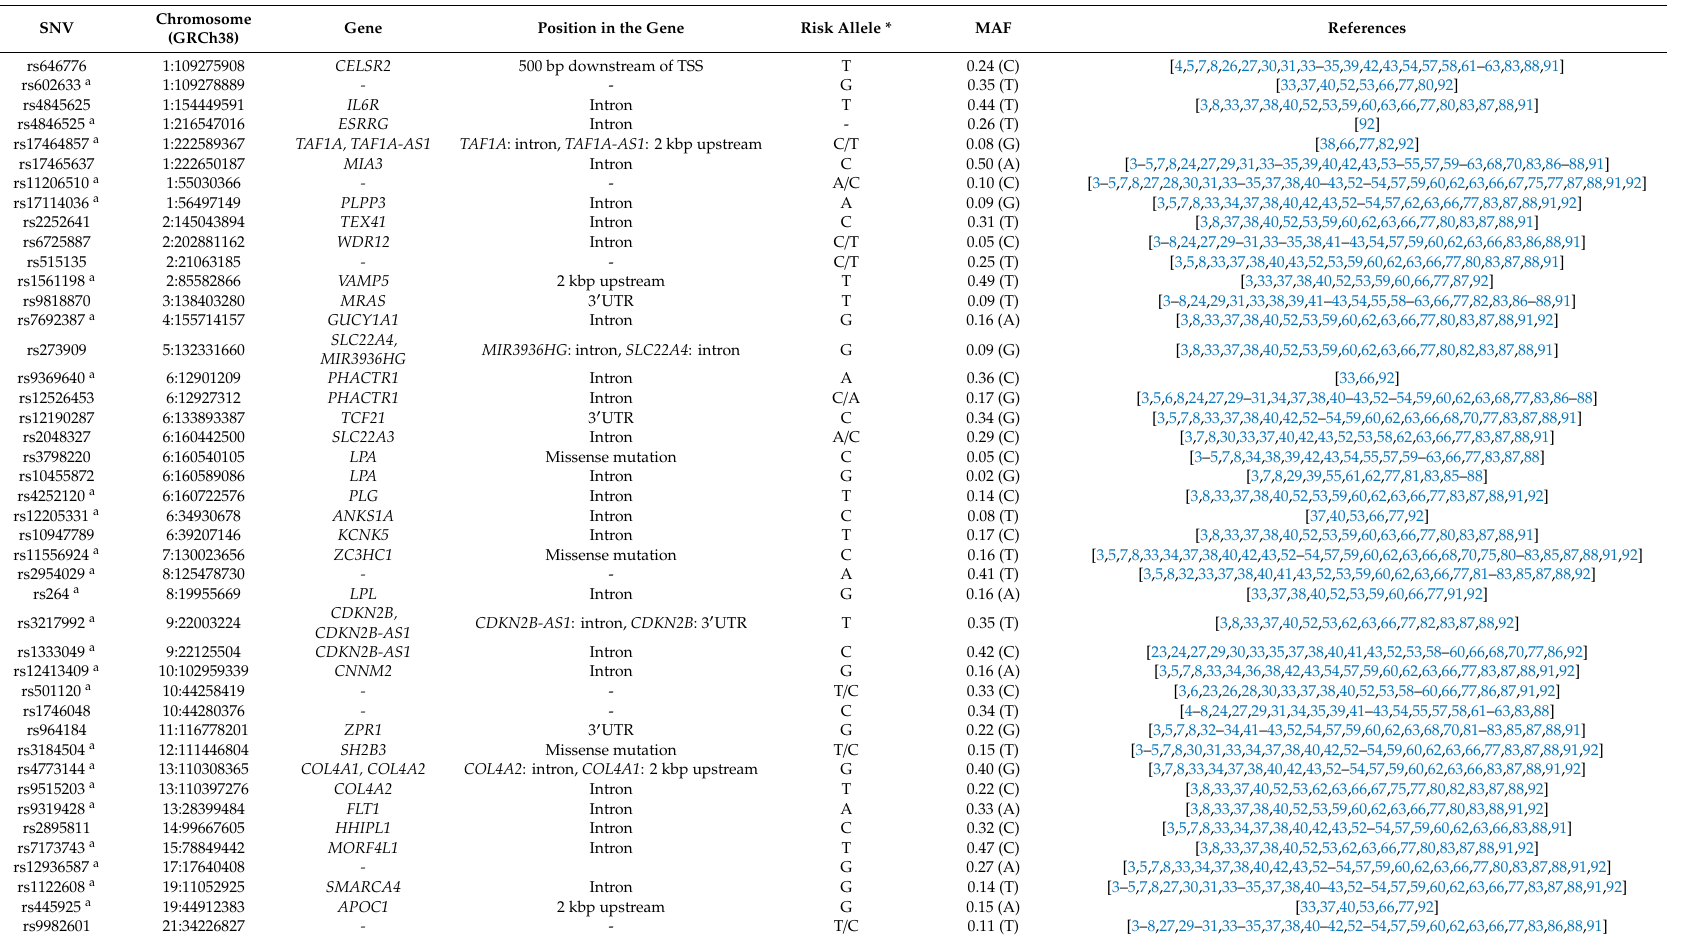
Table 1. Single-nucleotide polymorphisms (SNPs) associated with cardiovascular diseases (CVDs) according to research data from 2005 to